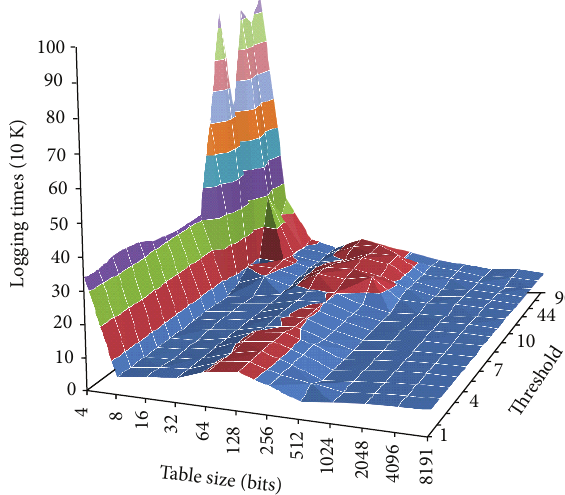
Figure 5: Relation among threshold, table size, and logging times.